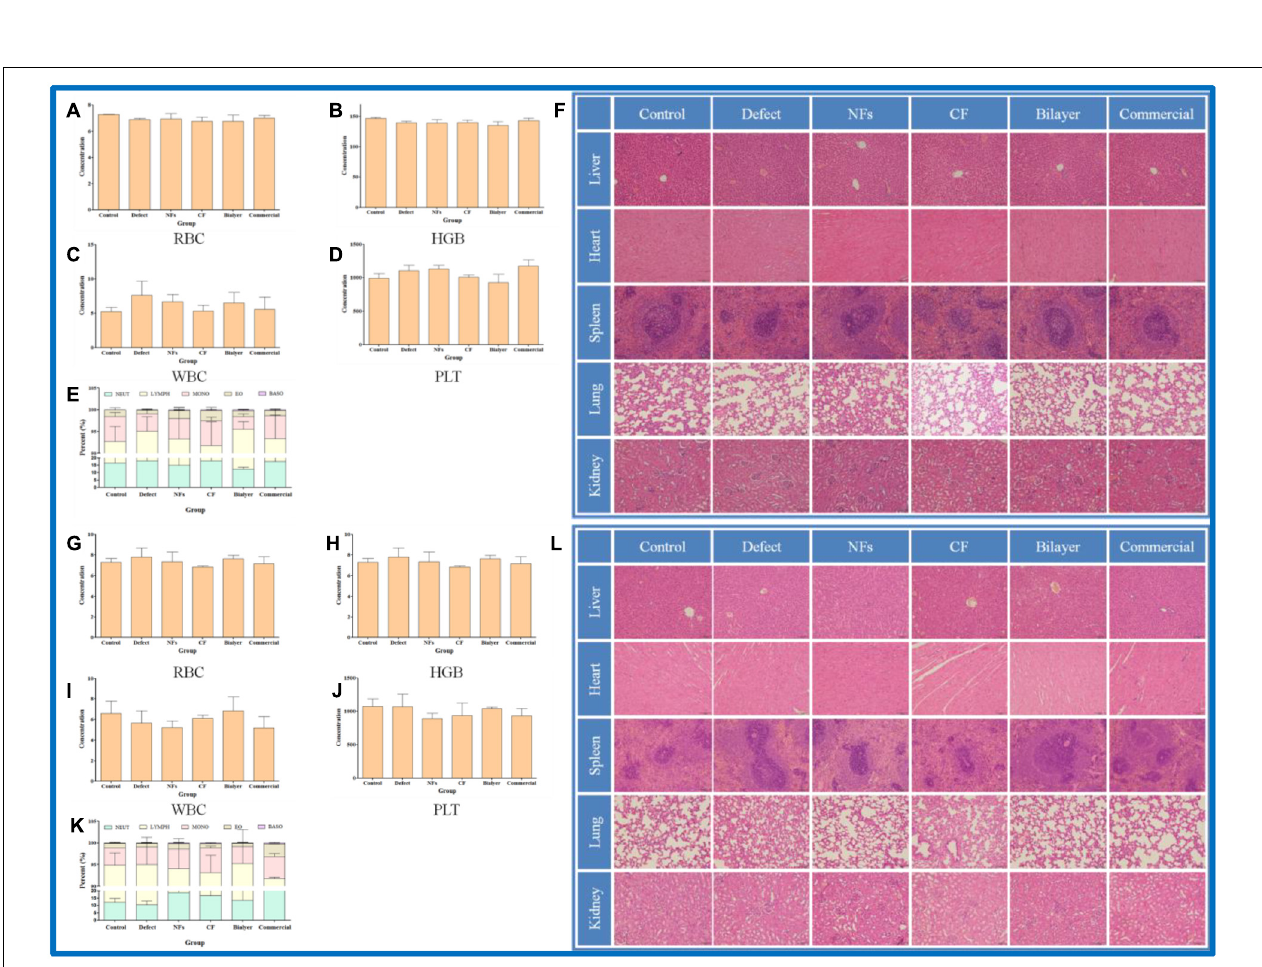
FIGURE 7 | Cell attachment 6 and 24 h after inoculation observed by confocal laser confocal microscopy.